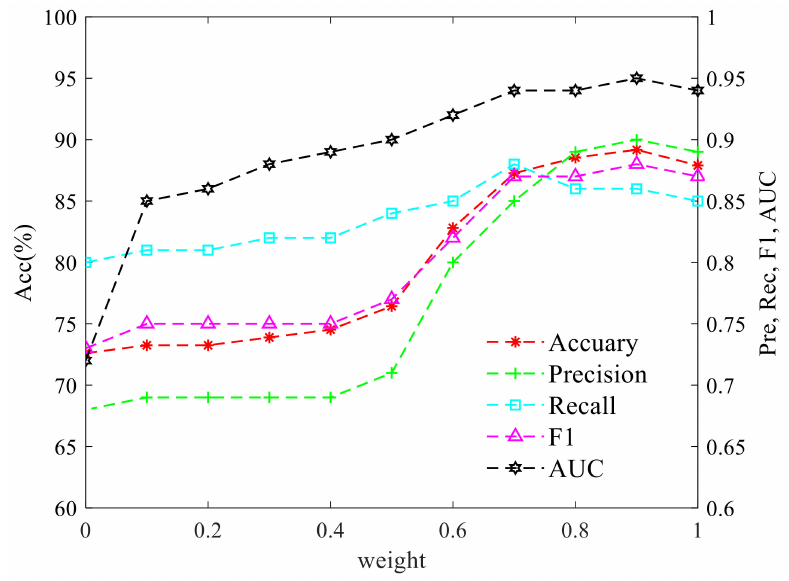
Figure 6. Classifier complementary weighted fusion analysis results with different fusion weights.